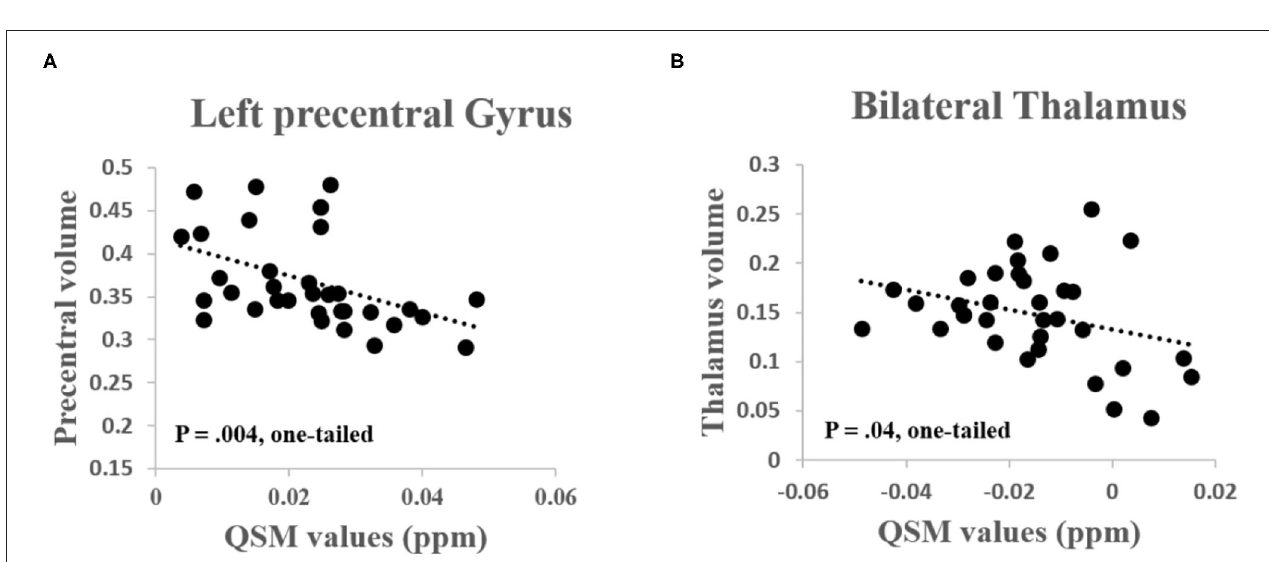
FIGURE 3 | (A) Significant negative correlation was found between the QSM values and GM volume in the left precentral gyrus ( R = − 0.44, P = 0.004, one-tailed) and (B) Bilateral thalamus ( R = − 0.32, P = 0.04, one-tailed) in patients with